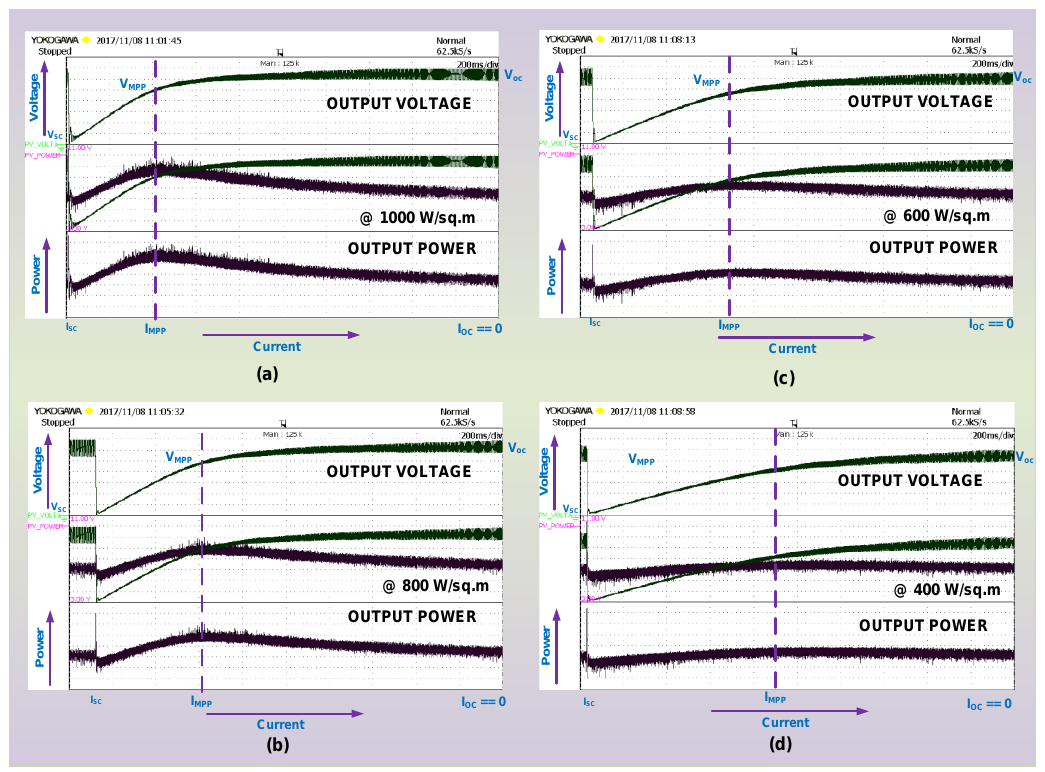
Figure10. Output Voltage and Powers of PV-Simulator for Different Irradiance Inputs. Figure 10. Output Voltage and Powers of PV-Simulator for Different Irradiance